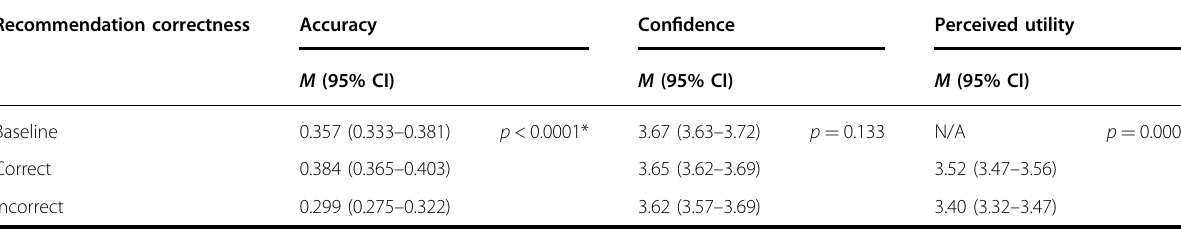
Table 2 Accuracy, con fi dence, and utility scores strati fi ed by recommendation correctness. Recommendation